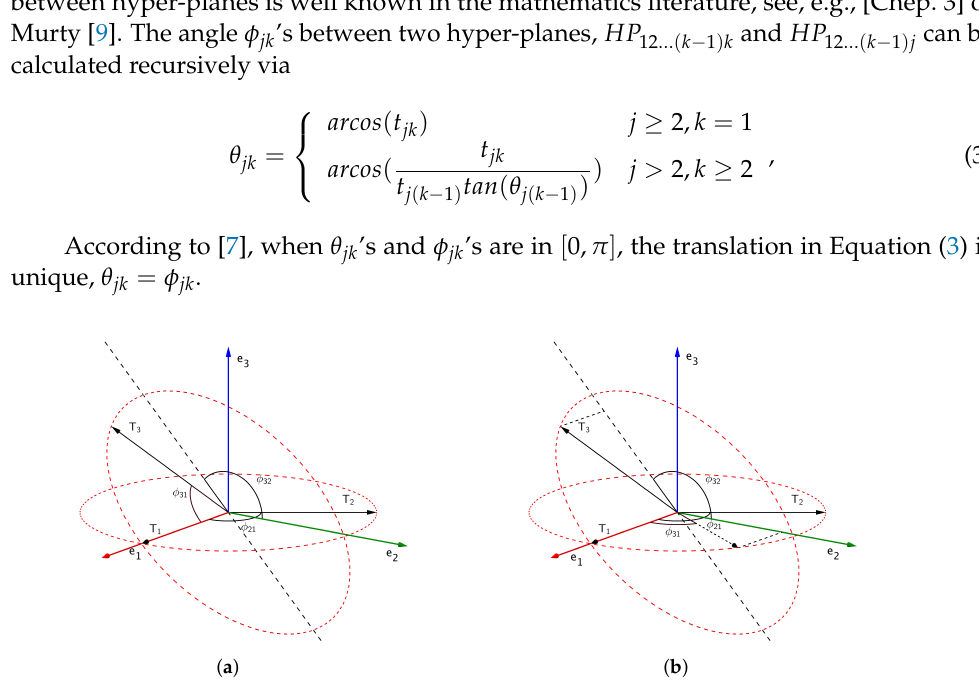
Figure 1. 3-dimensional illustration of HPC. ( a ) Interpretation of HPC method based on the idea of angles between hyper-plane. ( b ) Interpretation of HPC method based on Jacobi